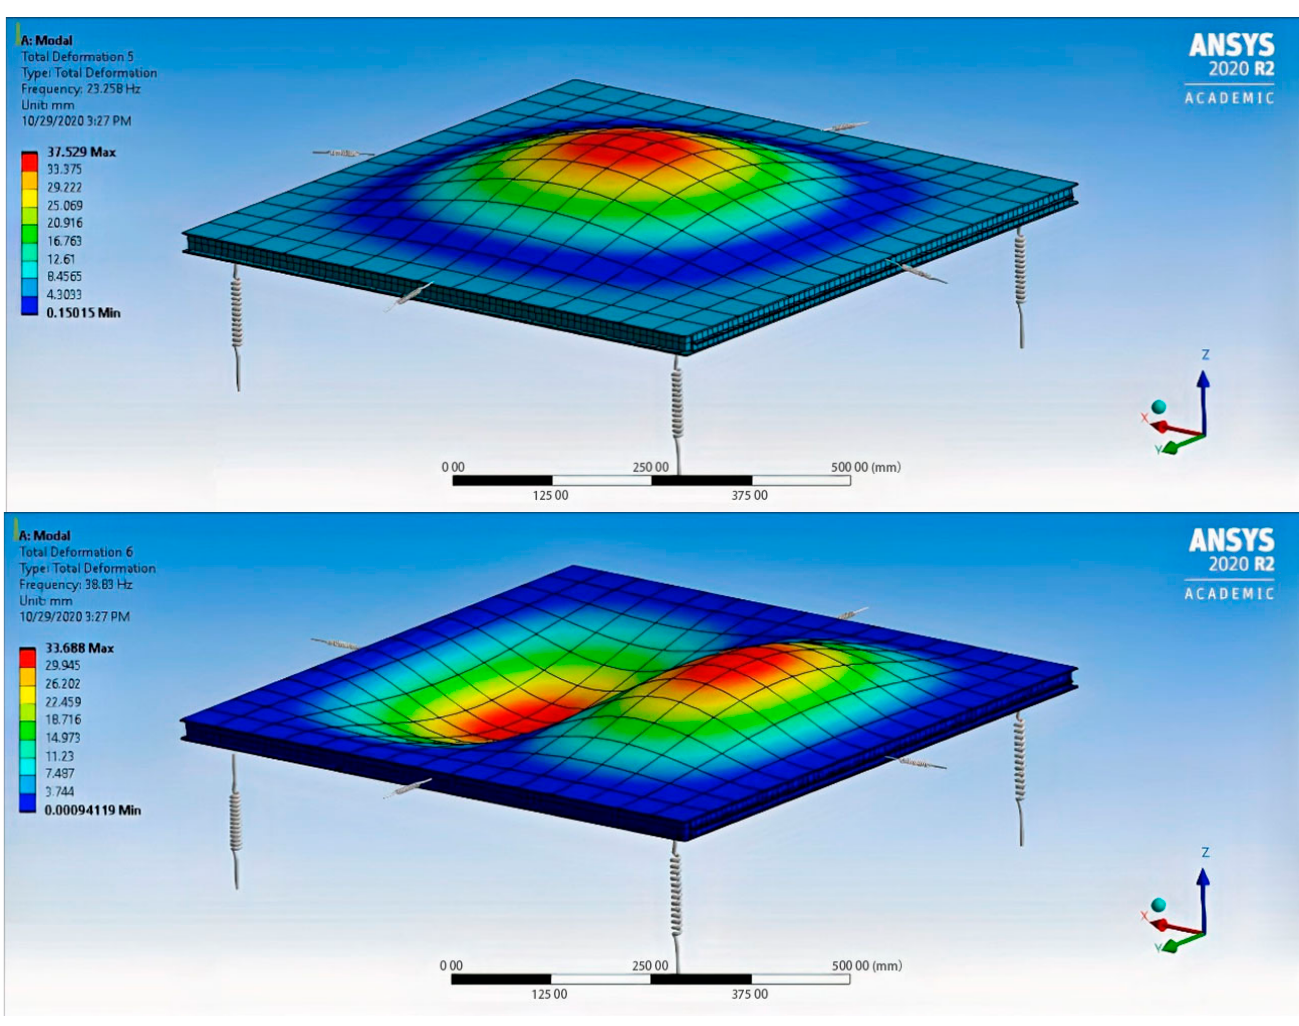
Figure 16. The mode shapes related to the second ( top ) and the third ( bottom ) eigenfrequencies in the simulation.